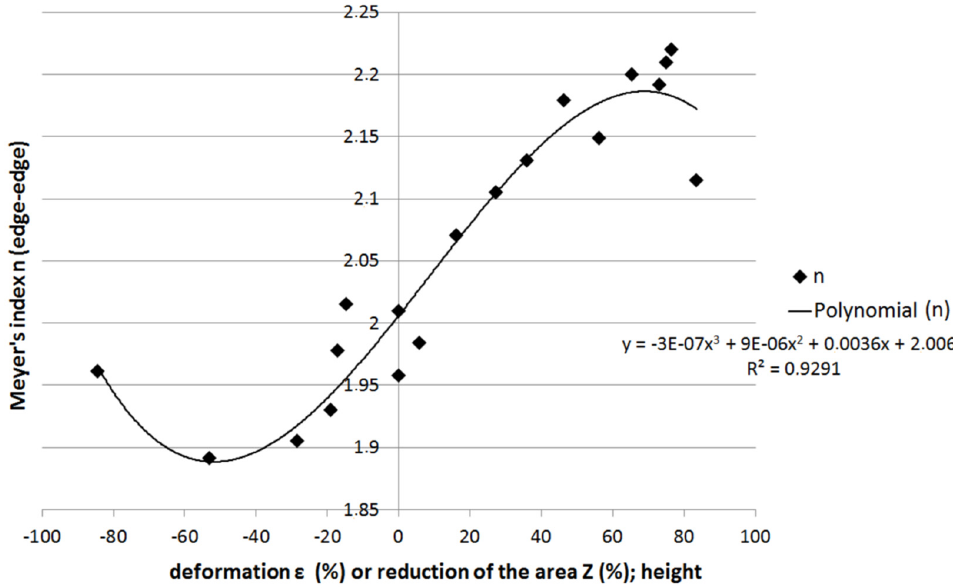
Figure 9. Influence of deformation on Meyer’s index n.